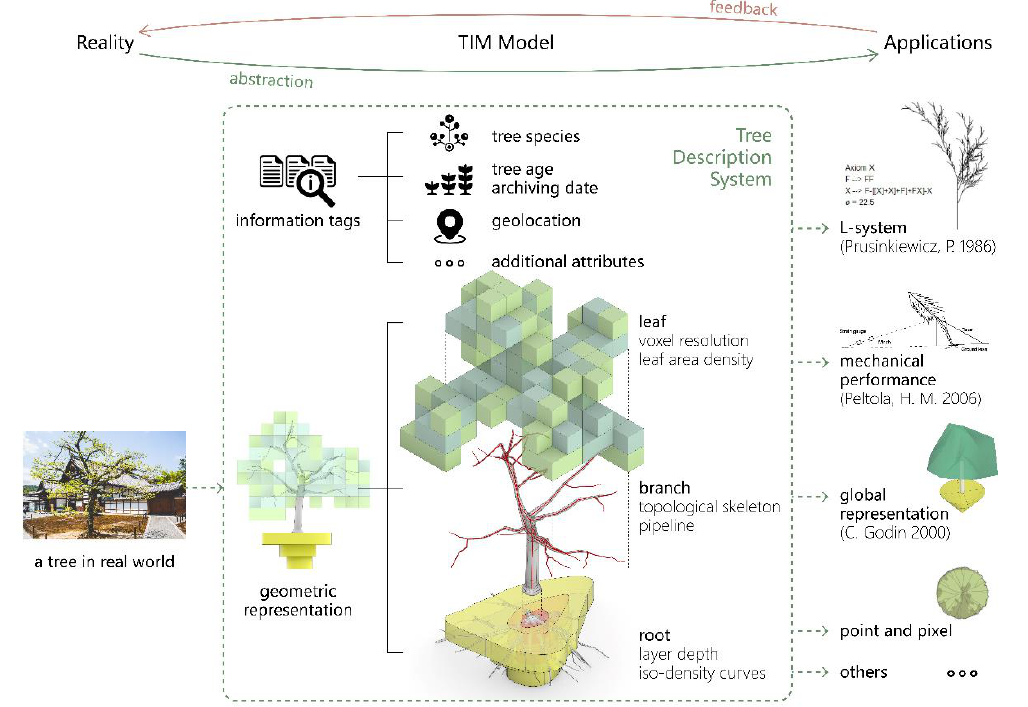
Figure 3. Role of TIM and its data structure. TIM integrates tree information required in multiple professions (see e.g., [48,75,95]). It functions as a media between trees in reality and their digital twins for specific applications.